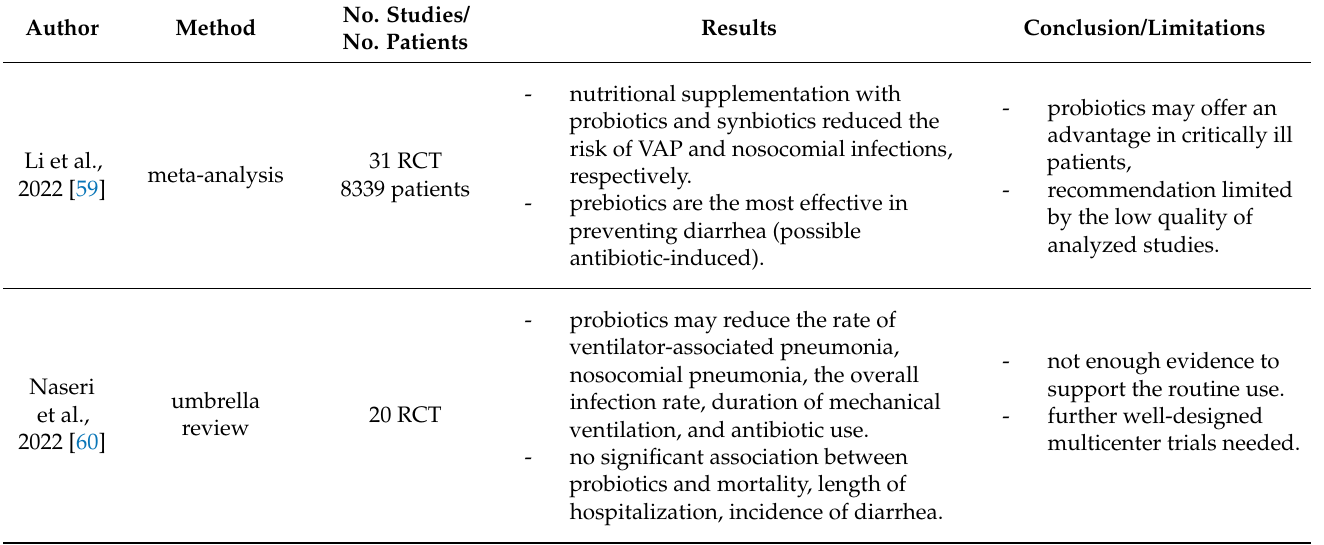
Table 3. Meta-analysis and systematic reviews of the effectiveness of probiotics, prebiotics, and synbiotics in critically ill patients